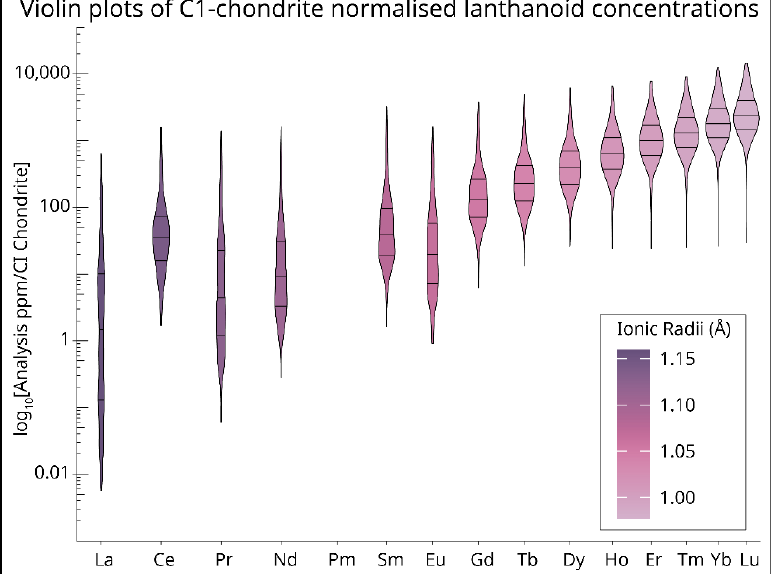
Figure 5. Violin plots of CI chondrite [72]-normalised lanthanoids for all filtered zircon analysed in this study. This plot shows the overall distribution by density estimation of lanthanoid concentrations in all filtered zircons presented in this study. The X -axis is spaced by ionic radii [73] and ordered by atomic number. Black lines across the fill of each plot represent the 0.25, 0.5, and 0.75 quantiles. Bandwidth of the density estimates was calculated using the Botev algorithm from the Provenance package [74].